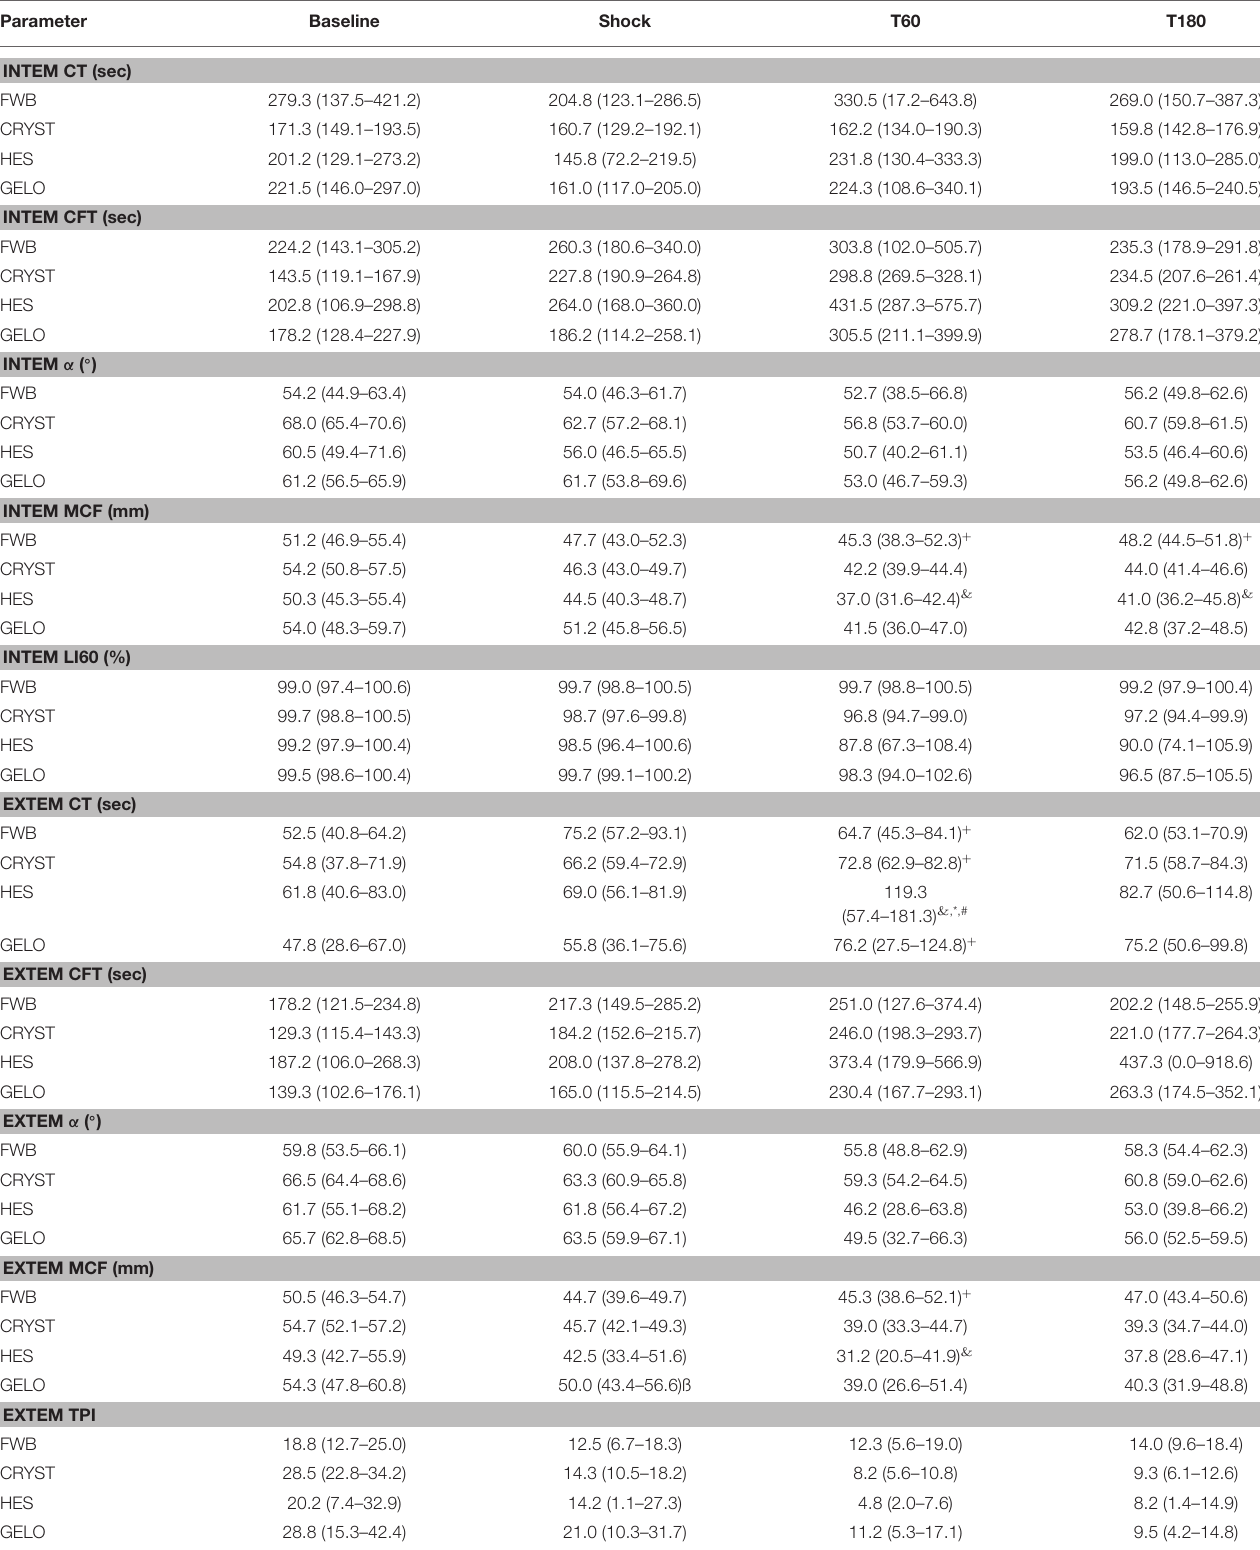
TABLE 2 | Rotational thromboelastometry parameters (mean, 95% confidence interval) in dogs ( n = 6 per group) with hemorrhagic shock given 20mL kg − 1 of either fresh whole blood (FWB), hydroxyethyl starch 130/0.4 (HES), 4% succinylated gelatin (GELO), or 80mL kg − 1 of balanced isotonic crystalloid (CRYST).